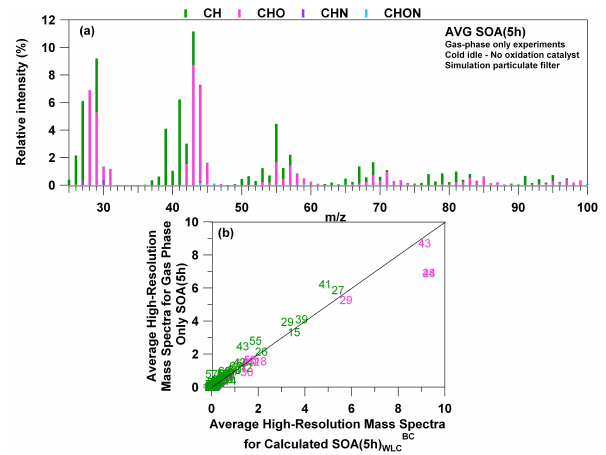
Fig. 12. Emission factors from in-use vehicles of POA, SOA and BC calculated with Eq.